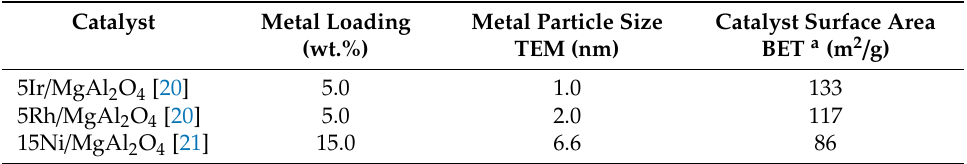
Table 1. Catalyst physiochemical characterization. Scanning transmission electron microscopy (STEM) images for the Ir and Rh catalysts are included in the supplementary information (Figure S1). Catalyst Metal Loading Metal Particle (wt.%)